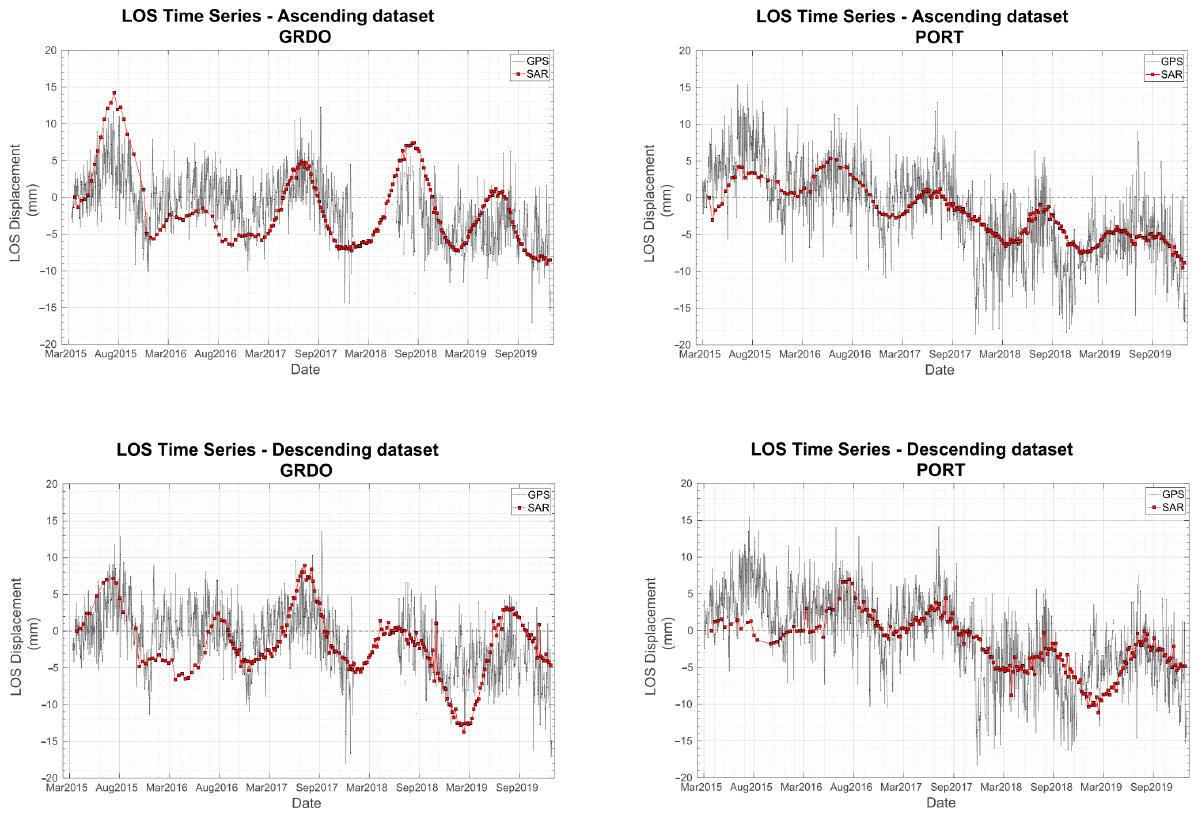
Figure 11. Ascending and descending LOS and GNSS Time Series (average PSs within a 600 m radius) of Grado (GRDO) and Portogruaro (PRTG) GNSS stations (black = GNSS; red = SAR).